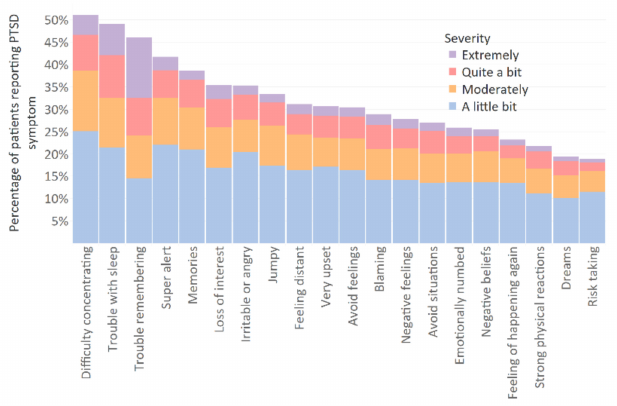
Figure A2. Frequency of post-traumatic stress disorder symptoms as measured by the PCL-5 at 6 months post-TBI.